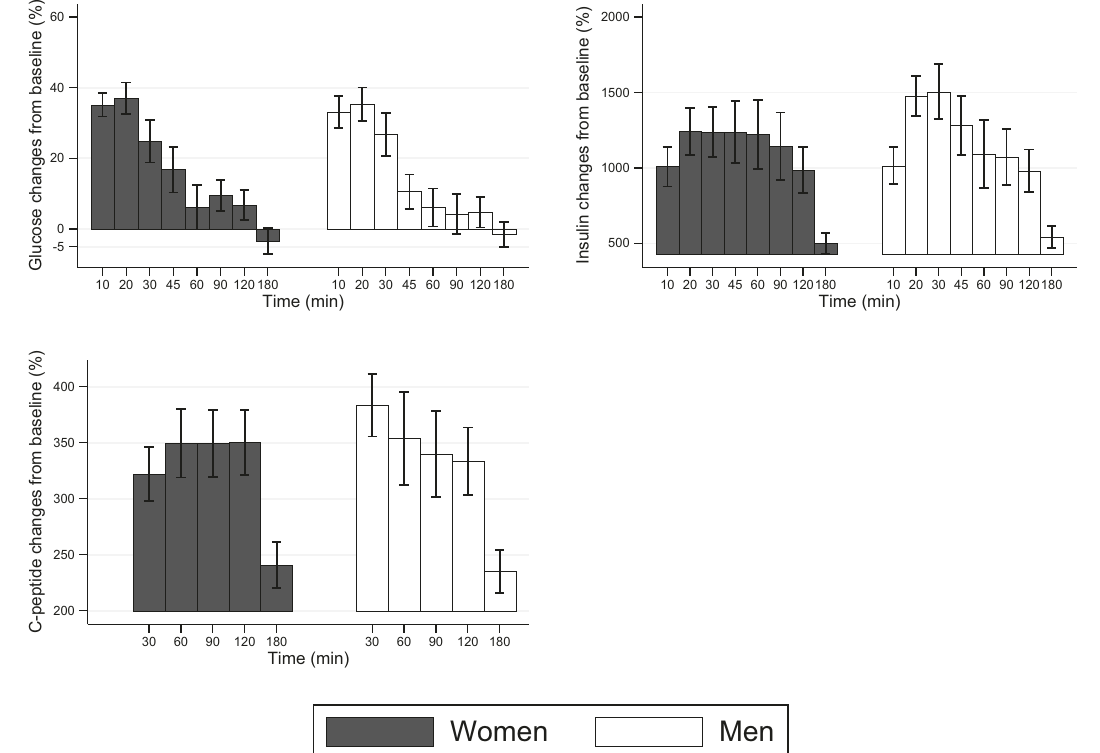
Fig. 2 Glucose, insulin, and C-peptide percentage changes in response to a balanced mixed meal. Values are glucose, insulin, and C-peptide percentage changes from baseline (mean ± standard error) observed in men and women after consumption of a balanced mixed of glucose homeostasis and type 2 diabetes in humans. Further con fi rmatory studies in elder people are required.